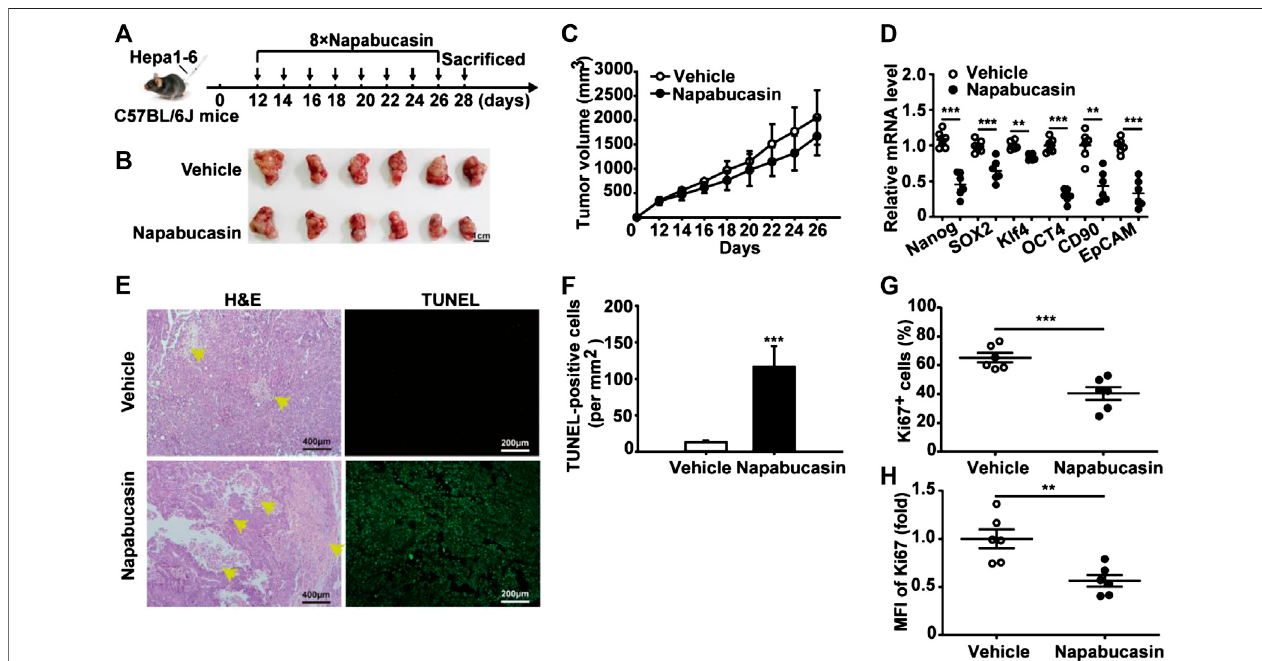
FIGURE 7 | Napabucasin induces necrosis in Hepa1-6 homografts in advanced stages. (A) C57BL/6J mice were inoculated with 5 × 10 6 Hepa1-6 cells in the left axilla, and intraperitoneally injected with napabucasin (20 mg/kg) or vehicle 12 days post-inoculation every 2 days for a total of eight injections. (B) Representative images of tumor tissues. (C) Tumor growth curves during the experimental period. (D) Stemness marker expression in tumor cells. Data were normalized to β -actin. (E) Representative images of H&E and TUNEL-stained tumor tissues. (F) Quanti fi cation of TUNEL-positive cells per mm 2 in tumor tissues from suitably treated mice. (G) ThefrequencyofKi67 + cellsintumortissues. (H) Ki67levelsintumorcells.MFI,mean fl uorescenceindex.Datarepresentsthemean ± SDofn (cid:2) 6andwereanalyzed with ANOVA (** P < 0.01 and *** P <